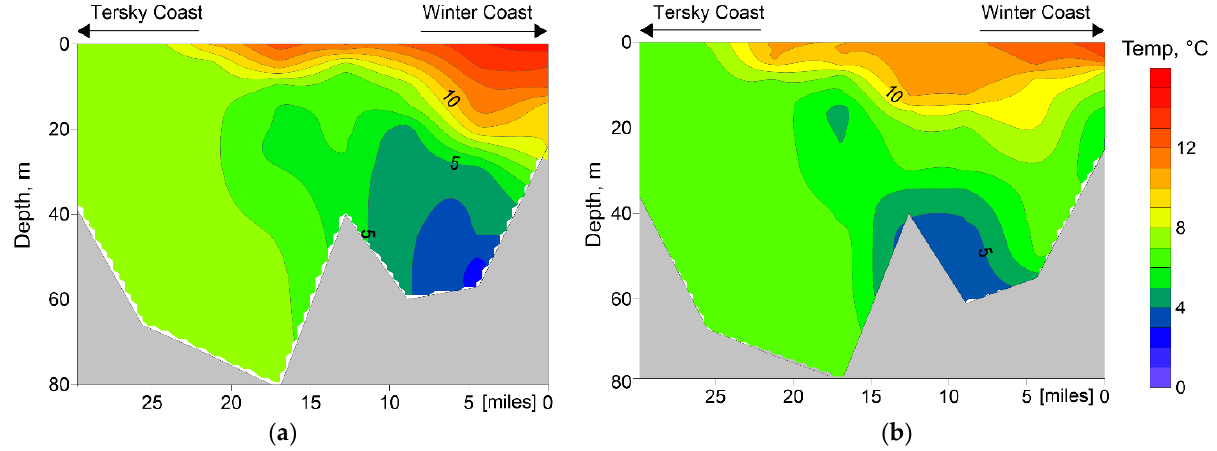
Figure 11. Temperature variations along the section crossing the Gorlo Strait during the ebb ( a ) and flood ( b ) tides on 30 – 31 July 2012. flood ( b ) tides on 30–31 July